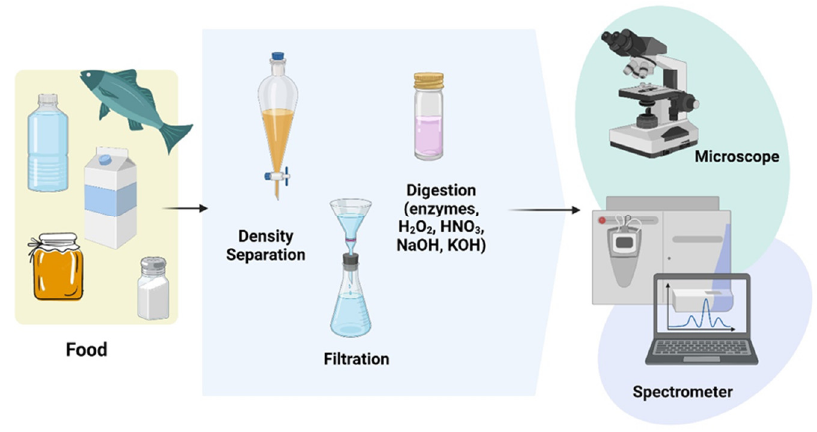
Figure 3. Microplastics detection stages. Created with BioRender.com.